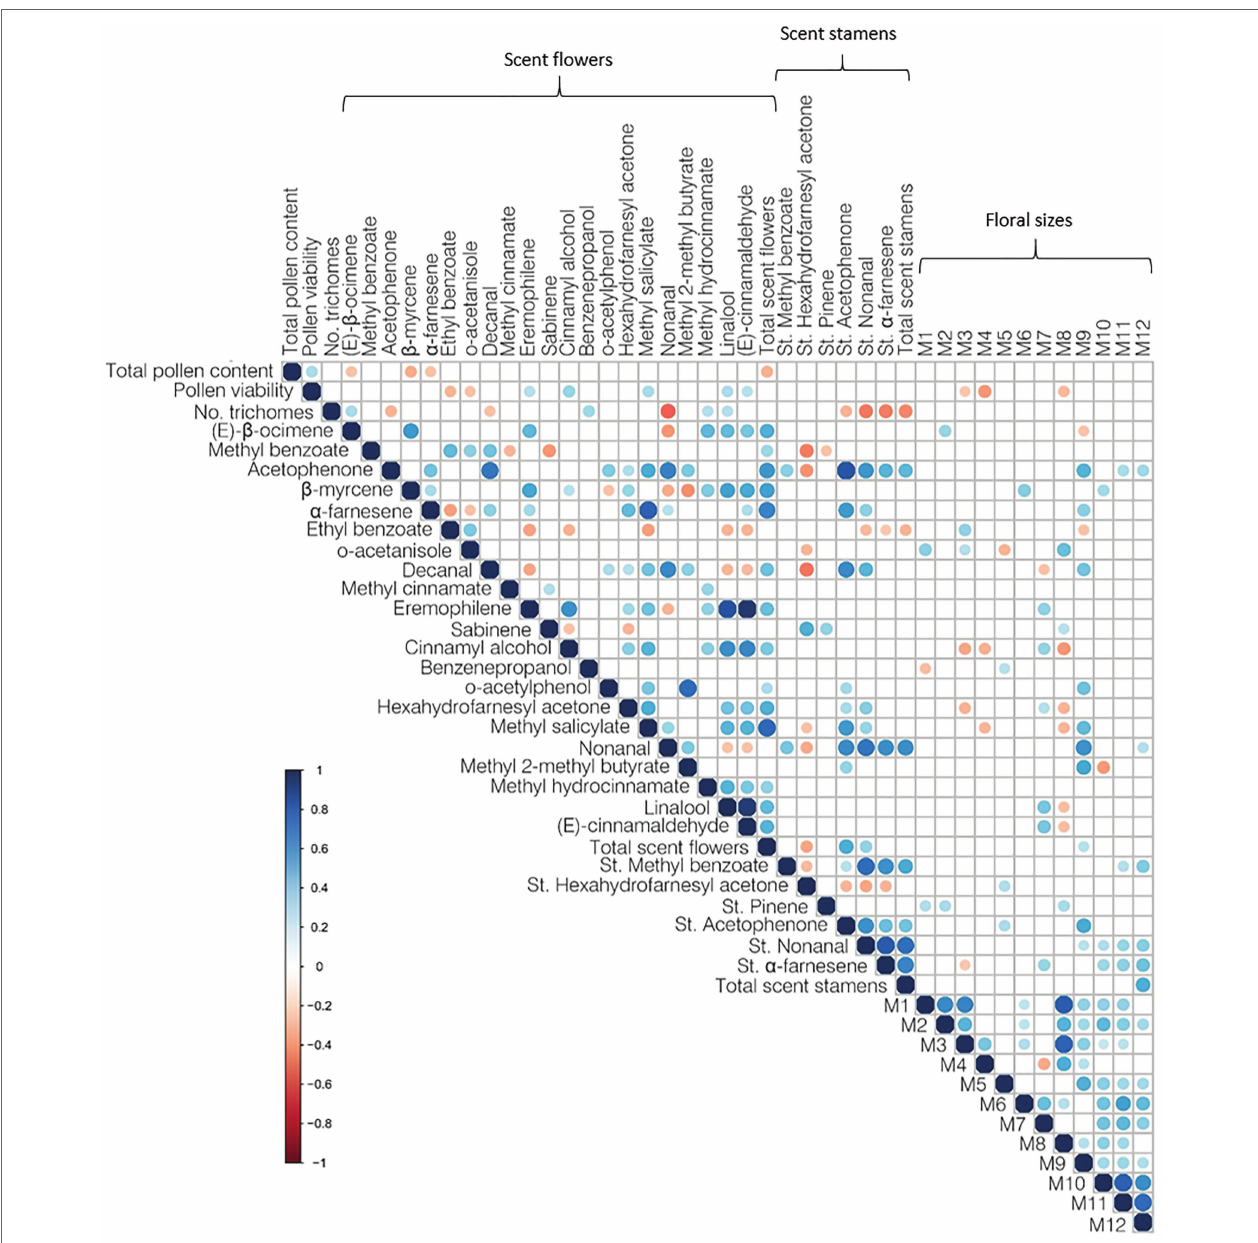
FIGURE 5 | Correlogram of the correlation matrix of floral phenotypic traits: pollen features, floral scent without stamens, scent of stamens, and floral sizes. Only significant Pearson’s correlations ( p < 0.05) are plotted.